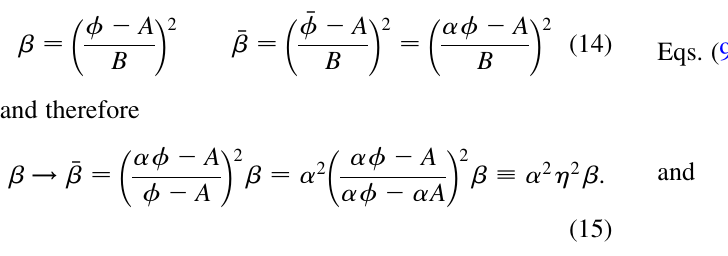
FIG. 12. (Color) Sketch of the beam location in the IR quadru- pole, doubling the quadrupole aperture and keeping the same (cid:1) (cid:1) as in Fig. 10.